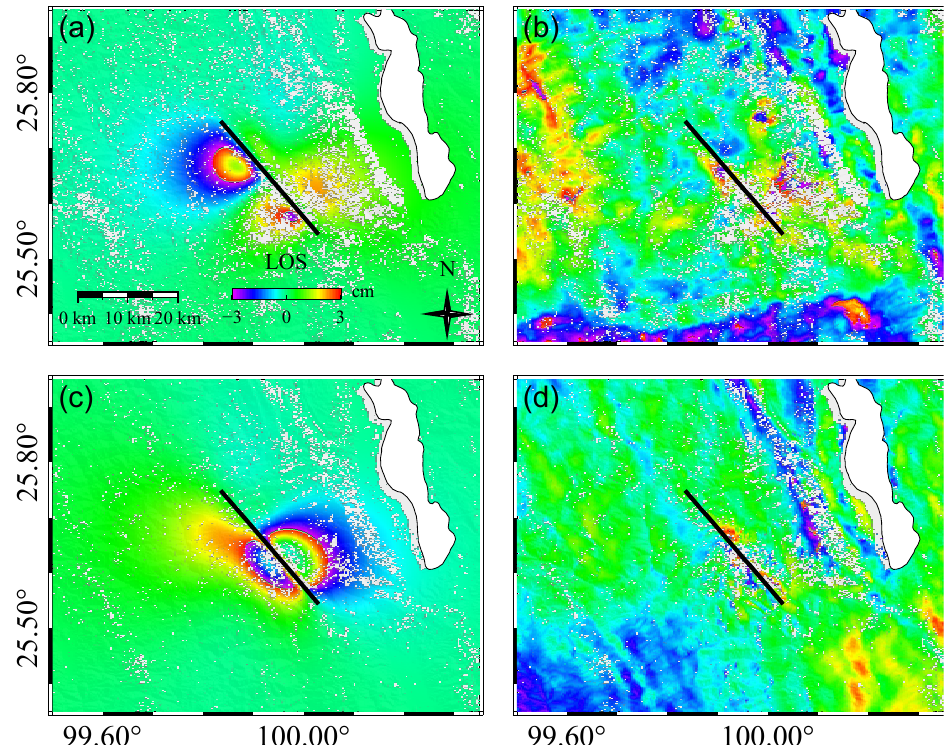
Figure 6. Simulated and residual interferograms. The solid black line is the surface projection of the fault top boundary. One fringe represents 6 cm LOS deformation. ( a , c ) Simulated interferograms of ASC and DSC, respectively. ( b , d ) Residuals of ASC and DSC.